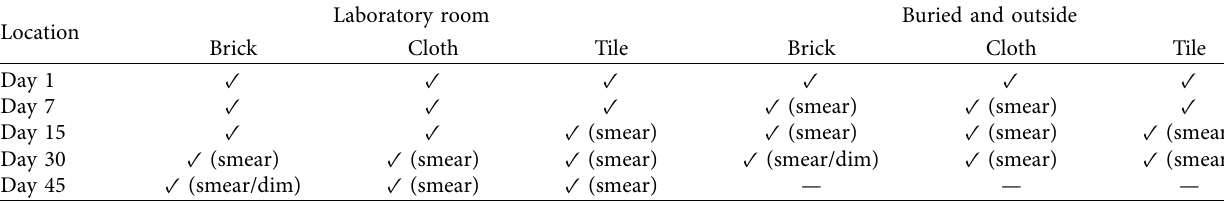
Table 1: Comparison of LAMP detection using gel electrophoresis in location, material surface, and